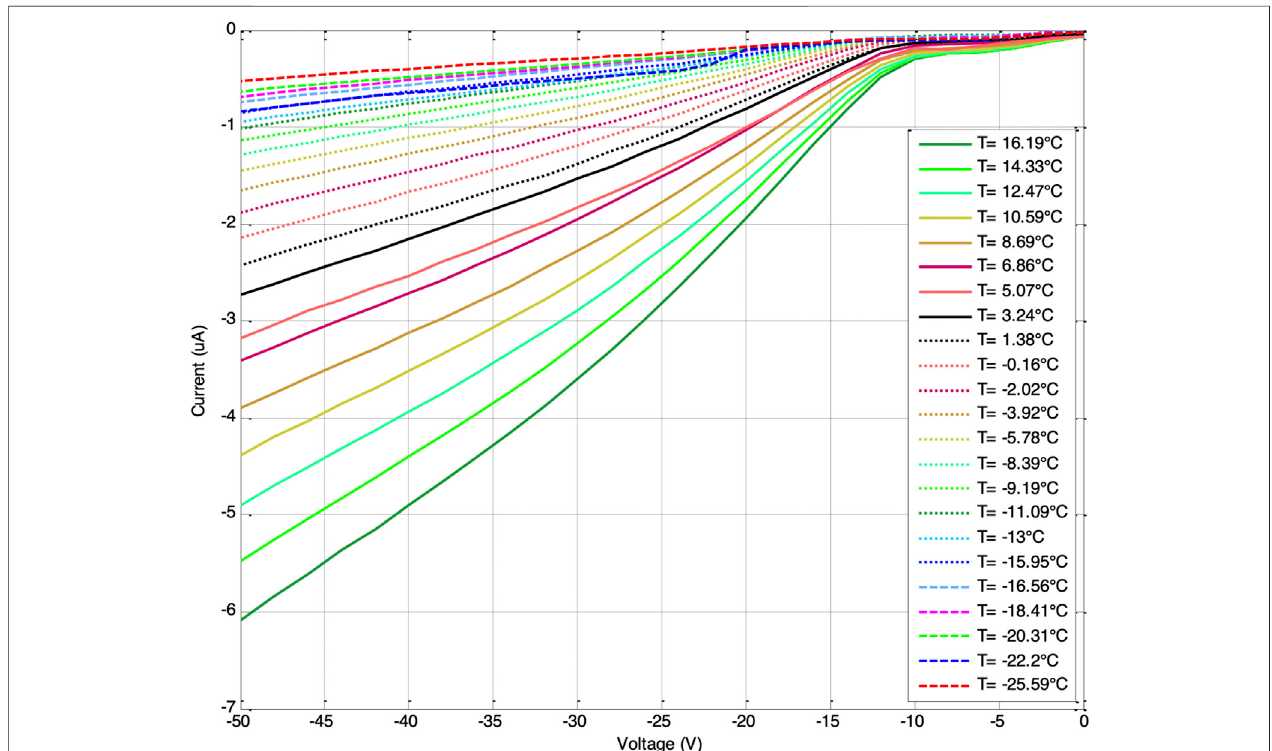
FIGURE 6 | Current – voltage curves at different temperatures with the FE-I4 chip switched off. Each temperature was measured by PT100 temperature sensors and is an average of 10 measurements.